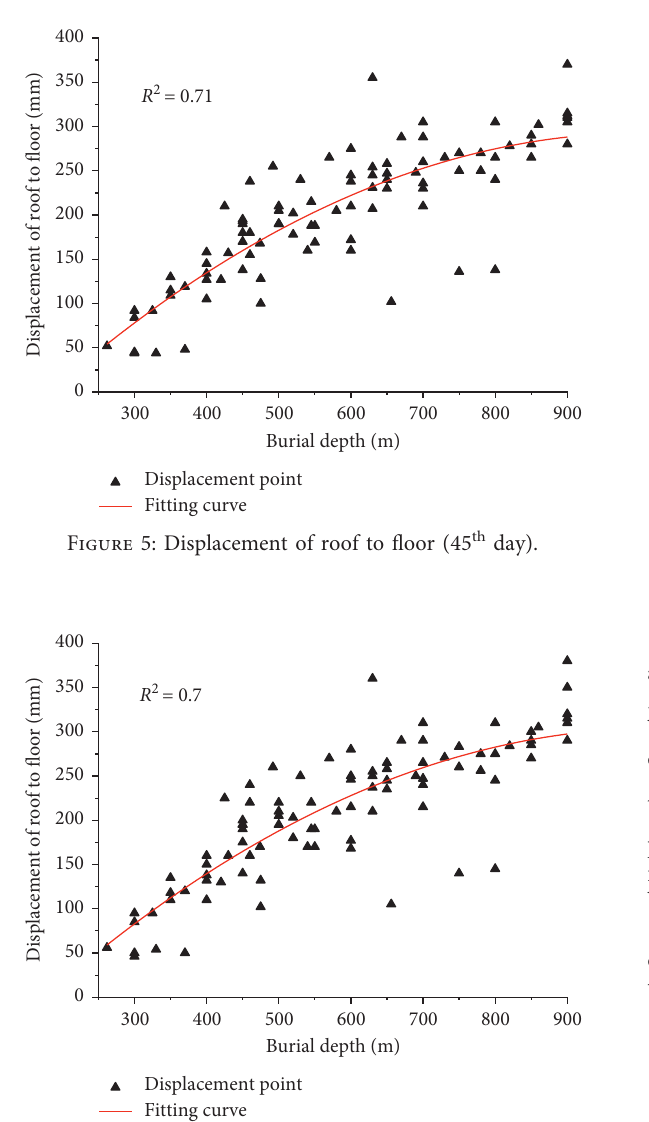
Figure 6: Displacement of roof to floor (40 th day).